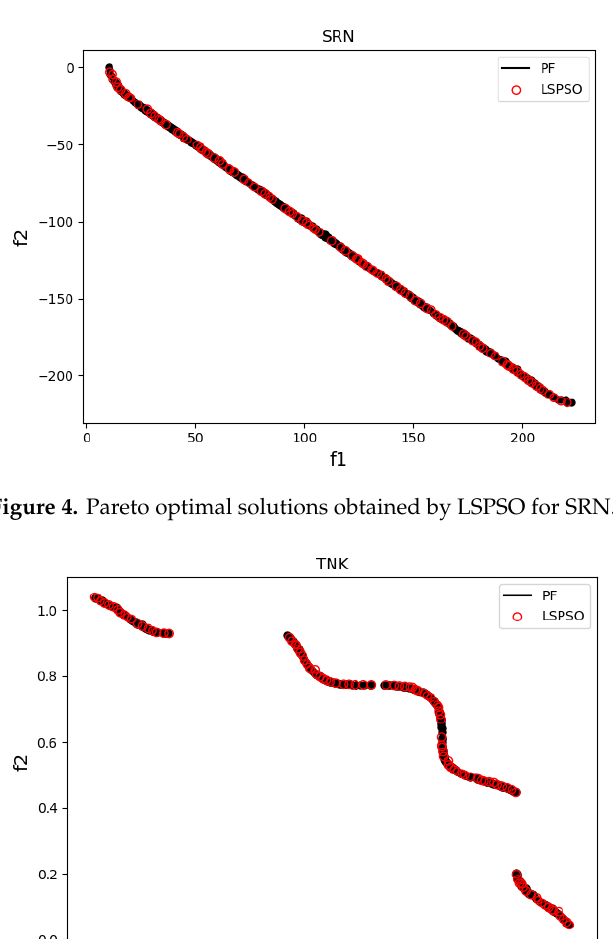
Figure 3. Pareto optimal solutions obtained by LSPSO for BNH.